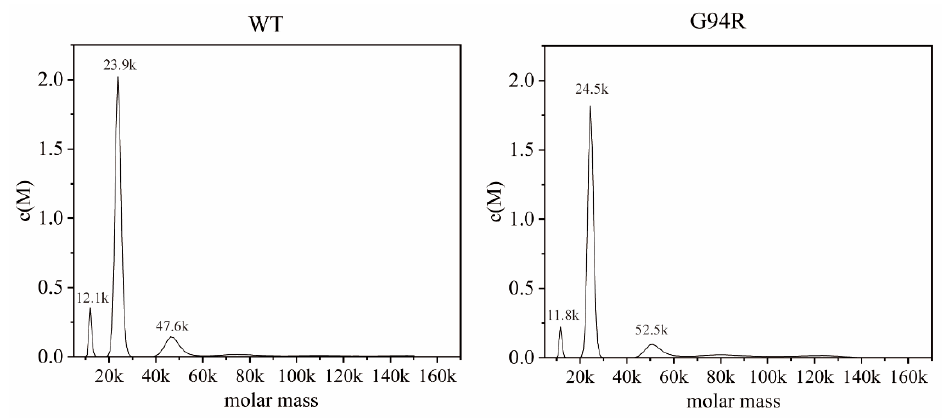
Figure 8. Sedimentation velocity analytical ultracentrifugation of WT and G94R proteins. The molecular weight of monomeric of WT and G94R with a 6 × His tag is approximately 24 kDa. The G94R mutation site is at position 94 of the heavy chain in the Chothia scheme, located right before the heavy chain CDR3 region. This indicates that this position could be critical for the stability of the CDR3 loop. The mutation of Gly to Arg at 94 would result in a favorable energy decrease, from − 349 to − 356.0 according to CISRR scoring. Through